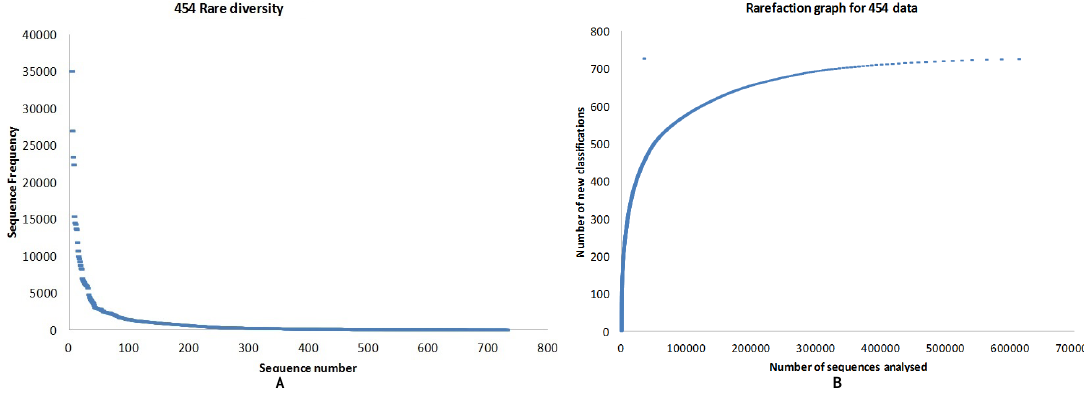
Figure 3. (a) Rare diversity and (b) rarefaction estimated based on 454 data analysed. Figure 3. ( a ) Rare diversity and ( b ) rarefaction estimated based on 454 data